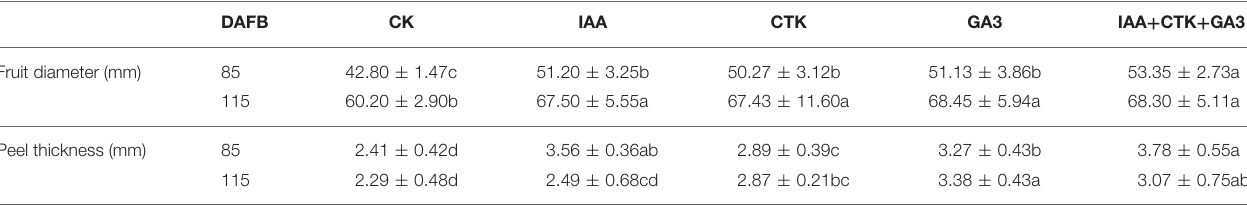
TABLE 4 | Changes of fruit size and peel thickness after hormone treatment. DAFB CK IAA CTK GA3 IAA + CTK + GA3 Fruit diameter (mm) 85 42.80 ± 1.47c 51.20 ±